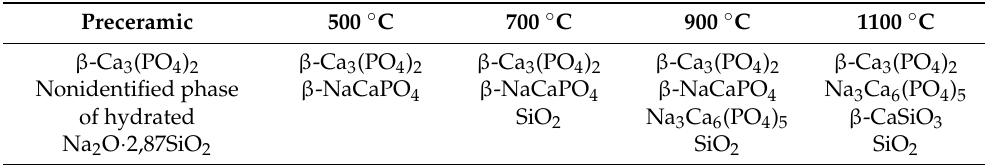
Table 1. Phase transformation of composition into preceramic and ceramic samples after heat treat- ment.